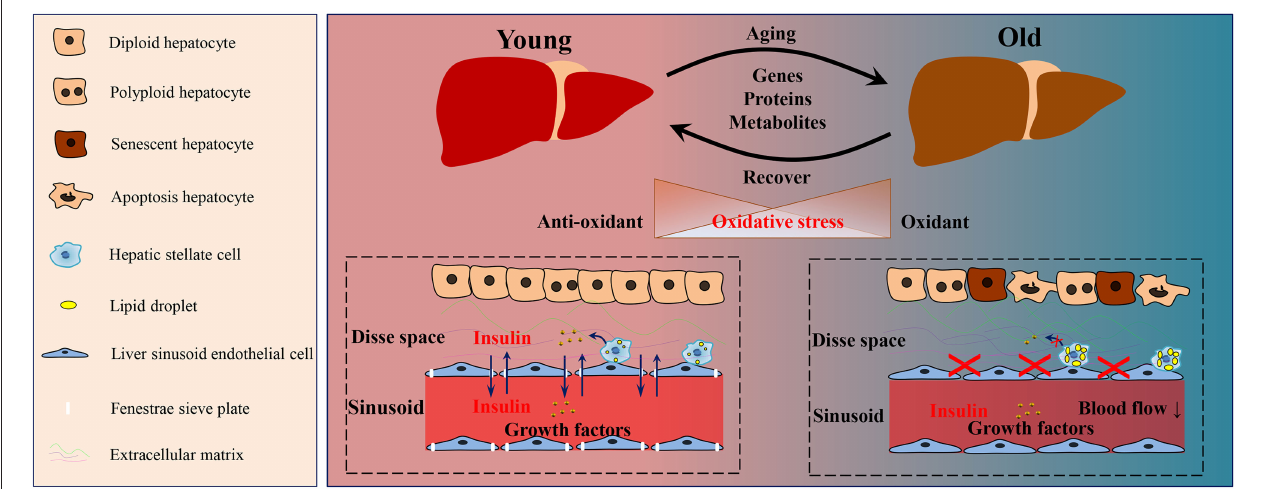
FIGURE 1 | Schematic diagram of the aging-related changes in the liver. During the aging process of the liver, a series of alterations was observed in genes, proteins and metabolites. The oxidative homeostasis was disrupted, thus lead to oxidative stress. During aging, the number of polyploid, senescent, and apoptotic hepatocytes increased. Hepatic stellate cells in the aged liver contained more lipid droplets and released less growth factors than those in the young liver. The defenestration liver sinusoid endothelial cells occurred during aging, and thus disrupted the substance exchange, such as insulin and growth factors. Moreover, more extracellular matrix was deposited in Disse space in the aged